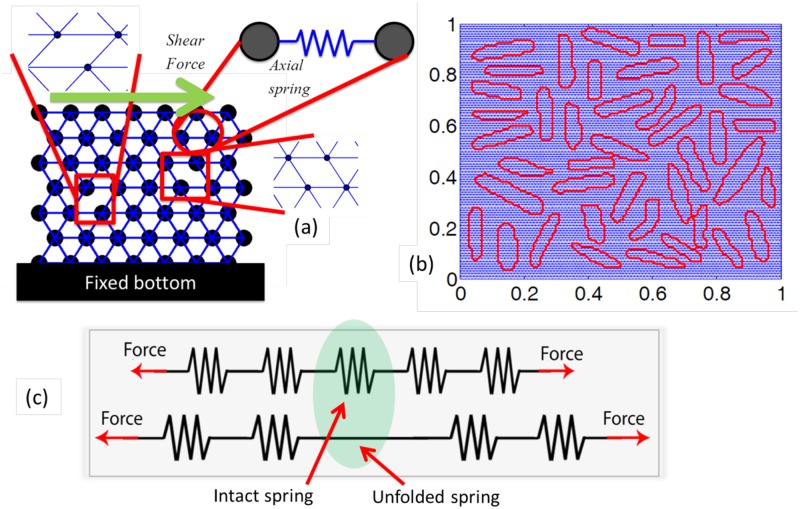
These figures demonstrate a schematic diagram of the lattice spring network, digitization of the biofilm domain and a schematic representation of the unfolding of springs.(a) The lattice spring network consists of a triangular mesh of spring elements. Each spring shows only axial stiffness. The mass remains concentrated at each node. The bottom of the network is fixed and shear force is applied at the top. (b) The digitized biofilm domain is displayed here. The red boundaries signify the boundaries for each of the bacteria. Blue portion is the mesh used to discretize the biofilm domain. (c) A schematic representation of the unfolding of springs. Under externally applied load, as the energy in a spring exceeds its unfolding threshold (the spring in the middle), it becomes straight and displays an infinite stiffness.